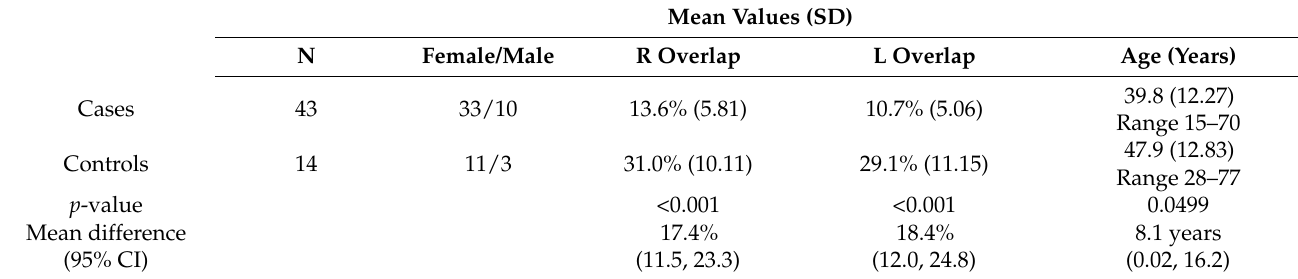
Table 1. Mean Values (Standard Deviations, SD) of percent of atlanto-axial residual facet overlap at the extreme of right and left rotation, and average difference between the 2 groups (95% confidence intervals [CI]), and age distribution among 43 cases and 14